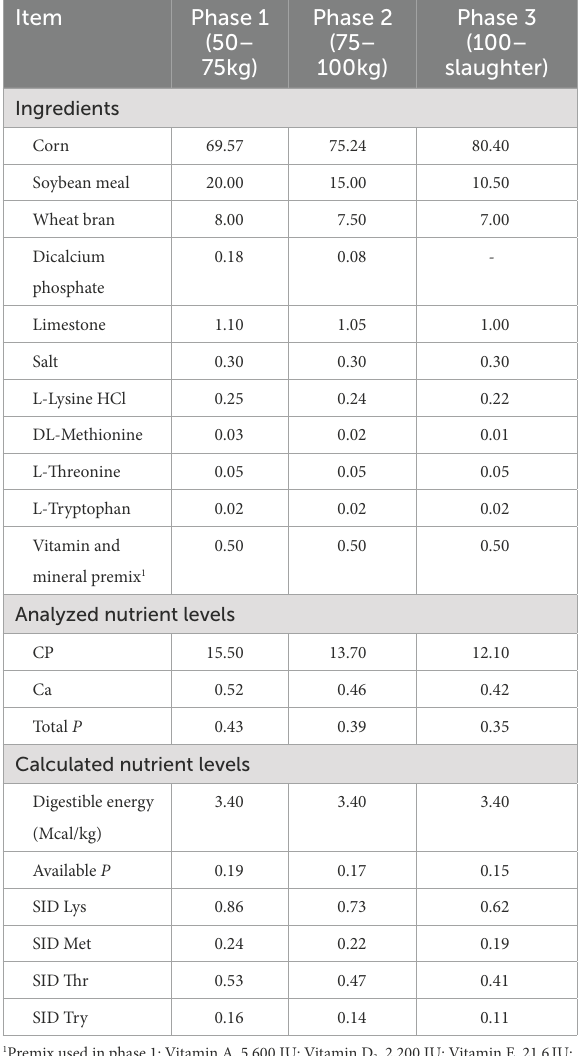
TABLE 1 Composition and nutrient levels of the basal diets (%, as-fed basis).